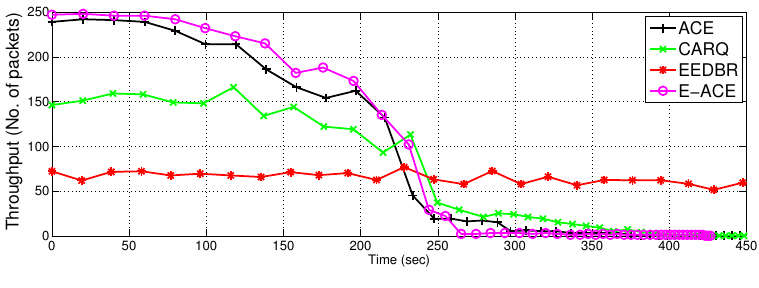
Figure 10. Throughput.